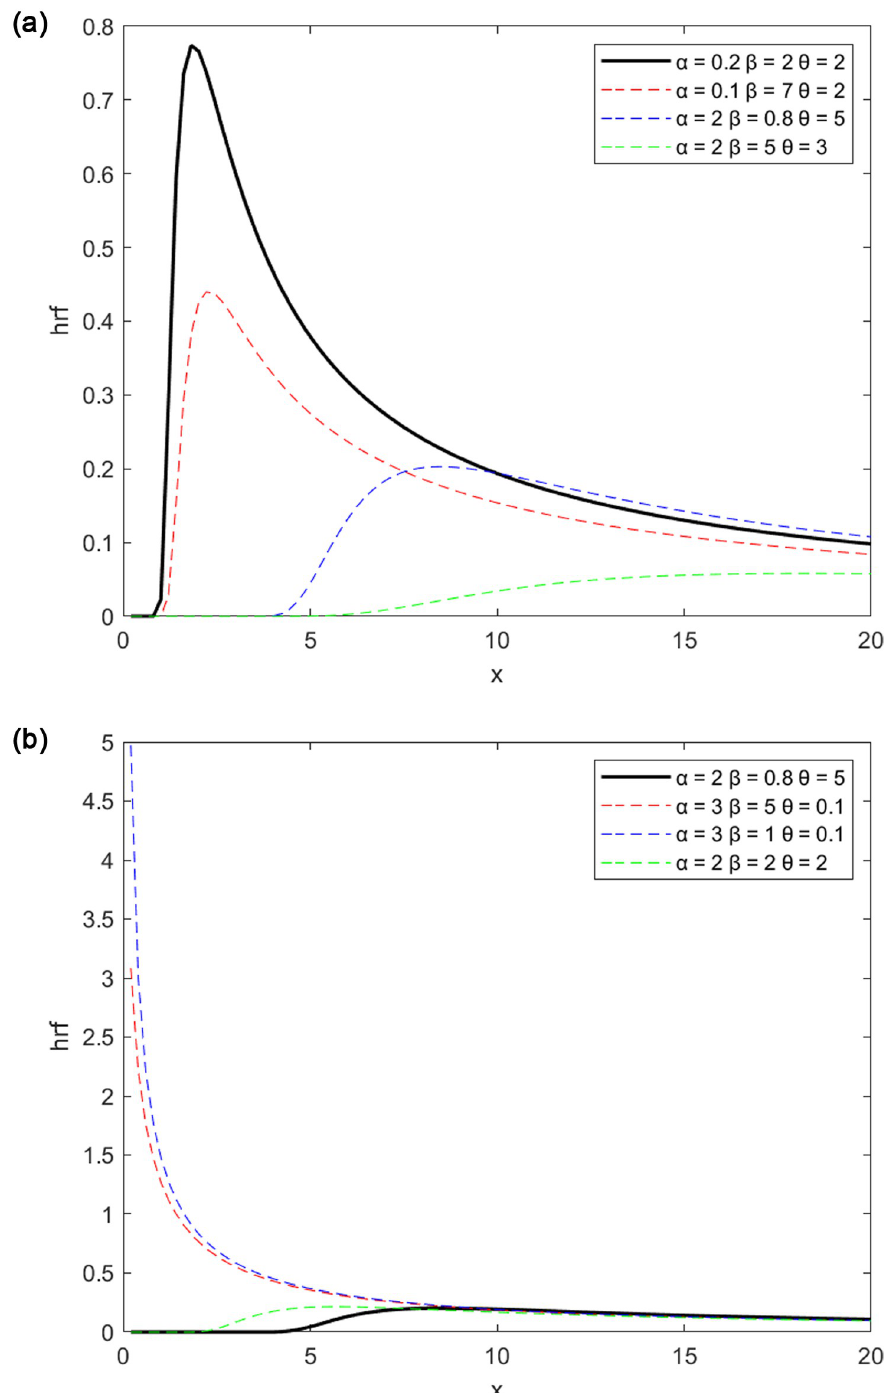
Fig 2. New MPTLILx’s hazard rate functions. (a) For different parameter sets. (b) For another additional group of parameters.